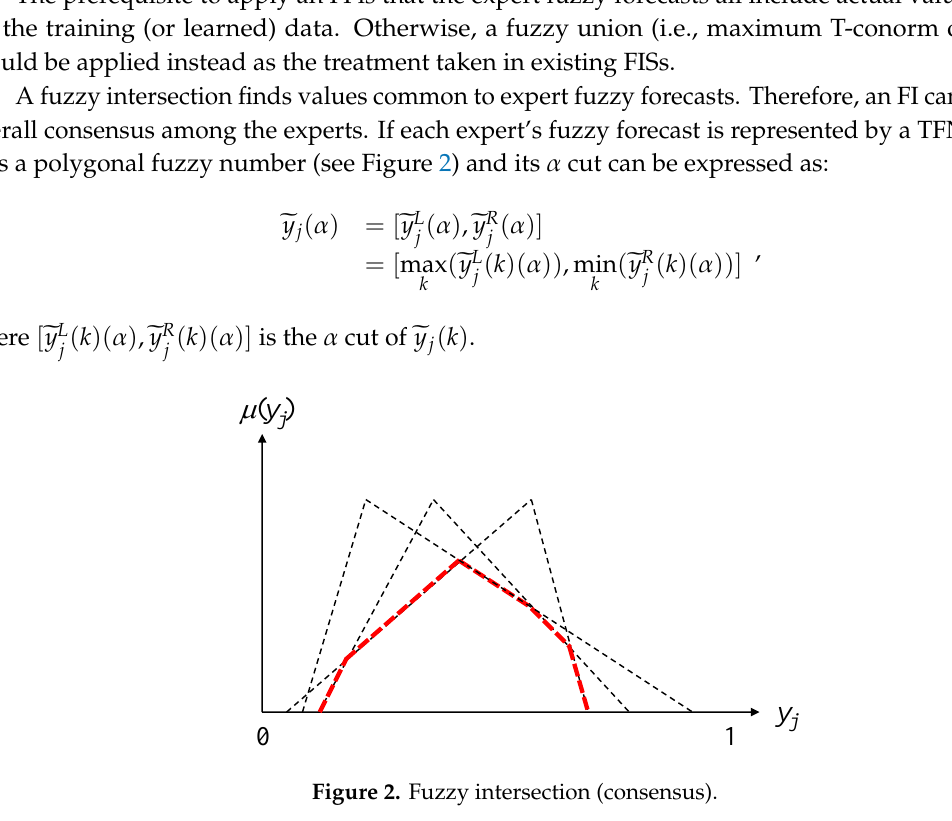
Figure 1. Proposed methodology procedure